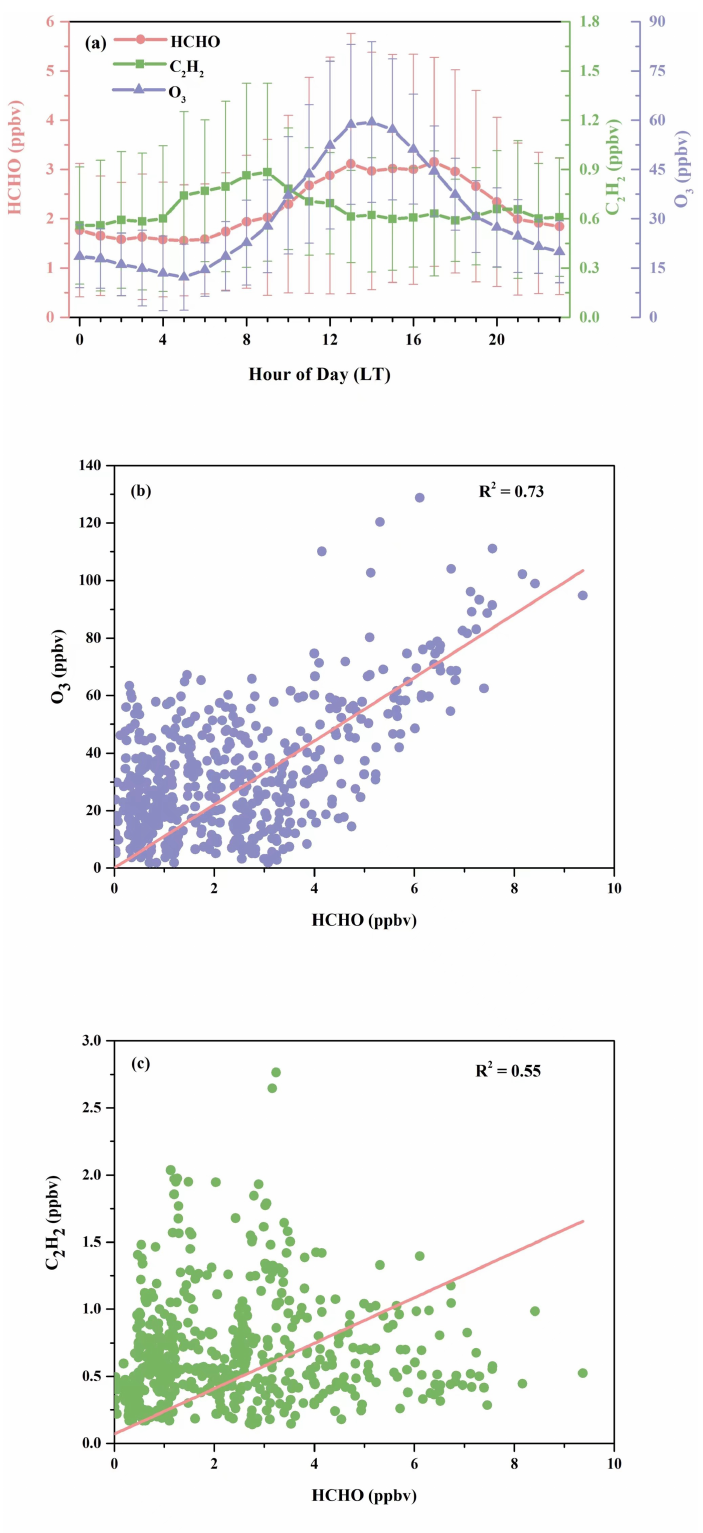
Figure 3. (a) Diurnal patterns of HCHO, O 3 , and C 2 H 2 , with the error bar indicating 1 standard deviation; (b) correlation between measured concentrations of HCHO and O 3 ; (c) correlation between measured concentrations of HCHO and C 2 H 2 .